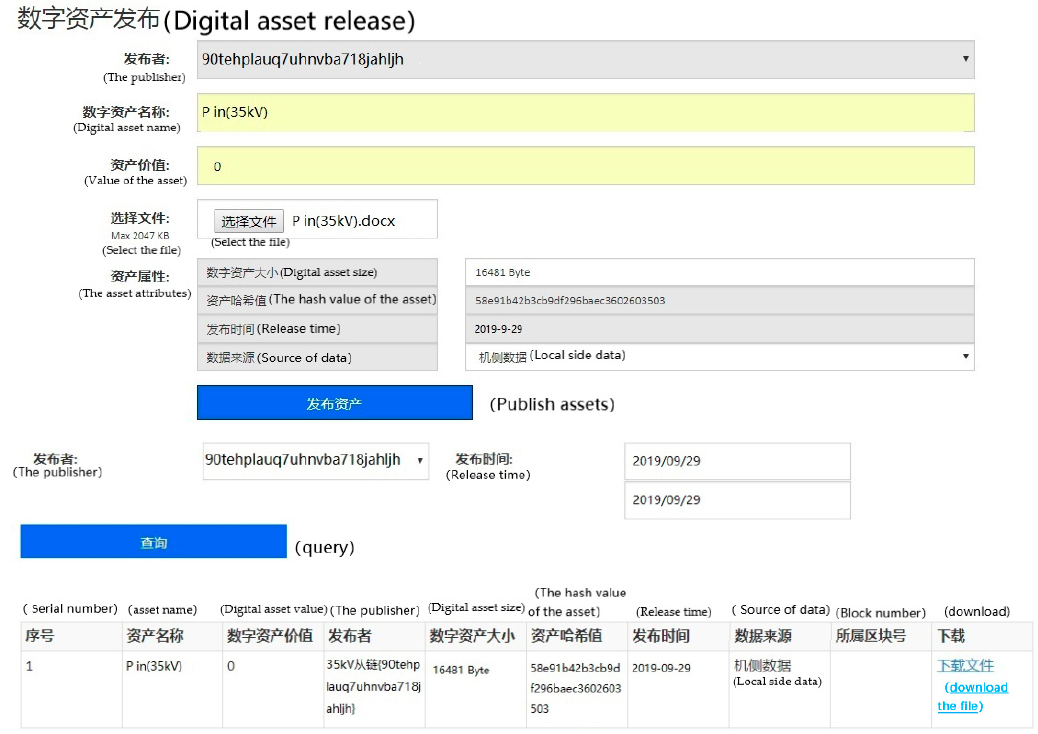
Figure A5. Chain35kV releasing scheduling data, and data asset information downloading.